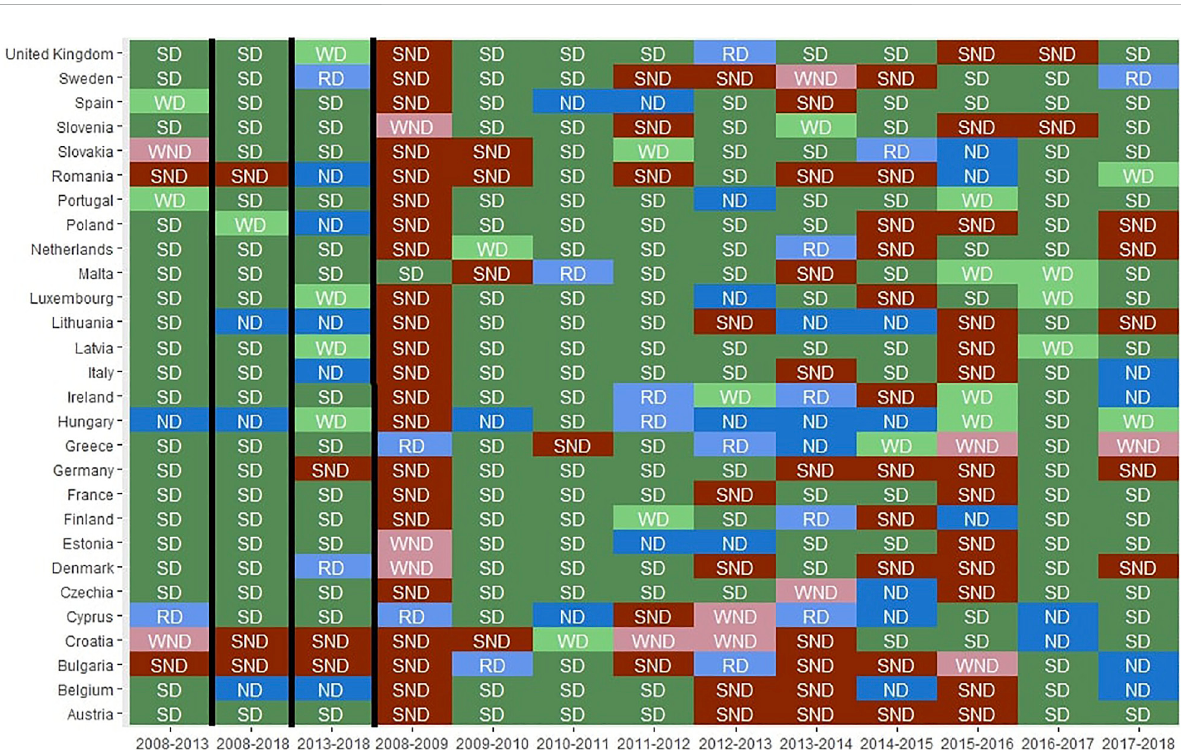
FIGURE 3 CO 2 intensity emissions decoupling. Source: authors ’ calculation based on EEA, (2020).